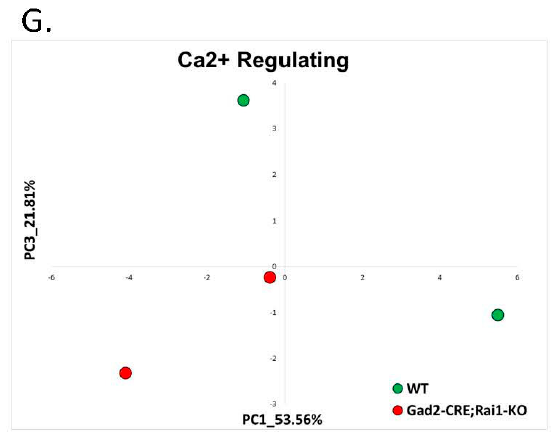
Figure 5. Smith-Magenis Syndrome: calcium target and calcium regulating signatures. ( A ) PCA based on the expression of calcium-target signature genes in the cortices of 3-week-old Nestin CRE Rai1 CKO (SMS model) mice compared to their controls. The control samples are denoted in green, while the SMS model samples are in red. ( B ) PCA based on the expression of calcium-regulating signature genes in the cortices of 3-week-old Nestin CRE Rai1 CKO (SMS model) mice compared to their controls. The control samples are denoted in green, while the SMS model samples are in red. ( C ) PCA based on the expression of calcium-target signature genes in the hypothalamus of 8-week-old Vglut2 CRE Rai1 CKO (SMS model) mice compared to their controls. The control samples are denoted in green, while the SMS model samples are in red. ( D ) PCA based on the expression of calcium-regulating signature genes in the hypothalamus of 8-week-old Vglut2 CRE Rai1 CKO (SMS model) mice compared to their controls. The control samples are denoted in green, while the SMS model samples are in red. ( E ) PCA based on the expression of calcium-target signature genes in the striatum of 12-week-old Gad2 CRE Rai1 CKO (SMS model) mice compared to their controls. The control samples are denoted in green, while the SMS model samples are in red. ( F ) PCA based on the expression of calcium-regulating signature genes in the striatum of 12-week-old Gad2 CRE Rai1 CKO (SMS model) mice compared to their controls. The separation of samples on the PC1–PC2 plane. The control samples are denoted in green, while the SMS model samples are in red. ( G ) PCA based on the expression of calcium-regulating signature genes in the striatum of 12-week-old Gad2 CRE Rai1 CKO (SMS model) mice compared to their controls. The separation of samples on the PC1–PC3 plane. The control samples are denoted in green, while the SMS model samples are in red